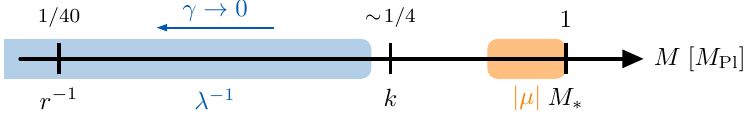
Figure 5 . Illustration of the parametric values of the dimensionful parameters of our model in units of the fundamental scale M . Note that the small hierarchy between k and 1 =r (cid:3) for the model to address the gauge hierarchy problem. The relation between the parameters k , and M is in principle arbitrary, however our dynamical mechanism requires that (cid:3) good approximation, see